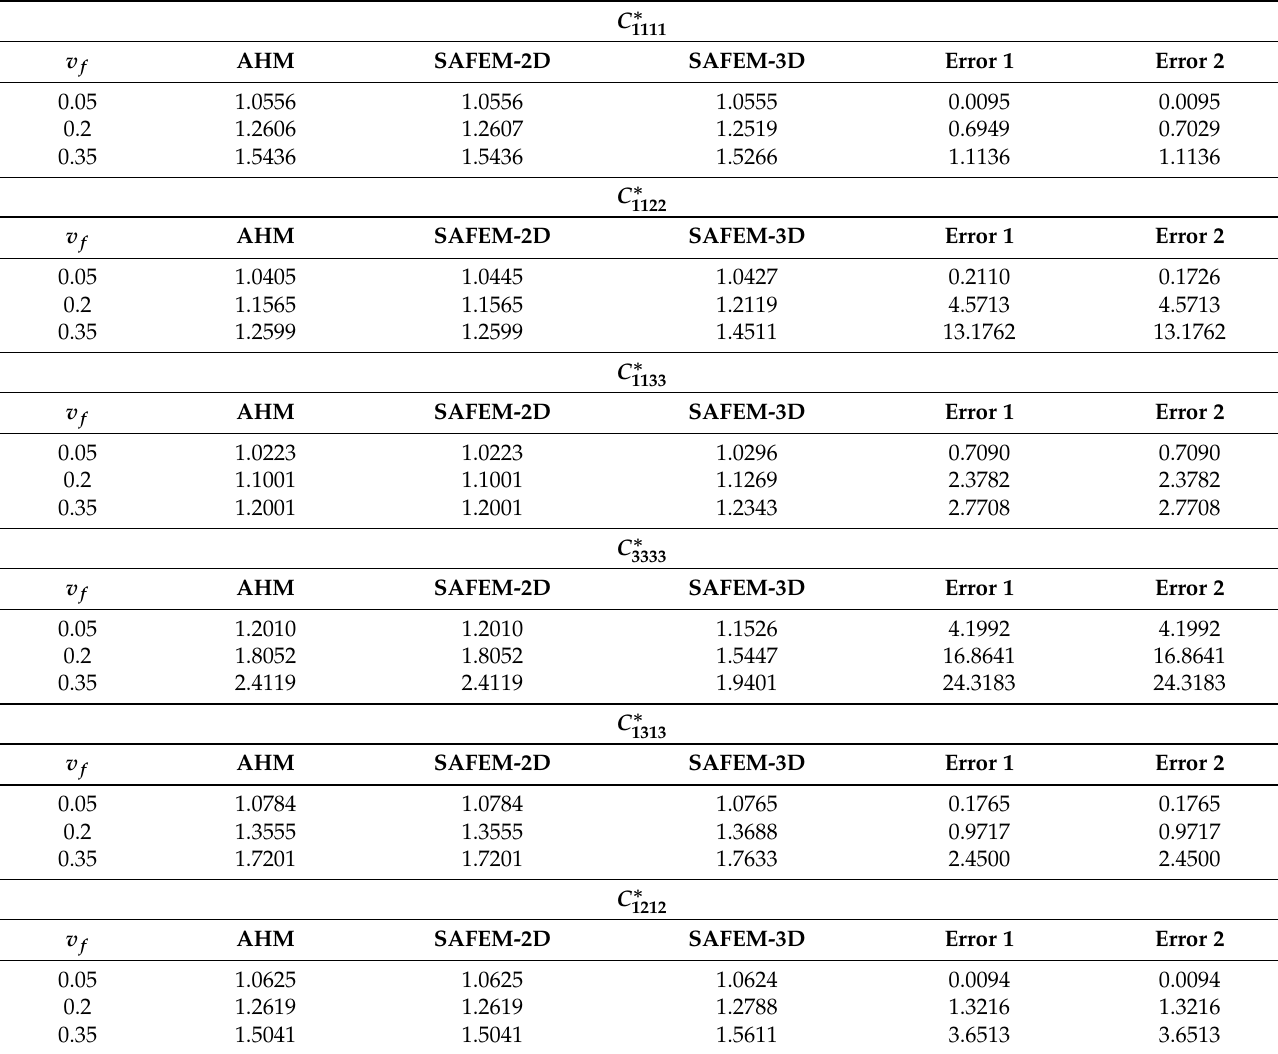
(cid:12) (cid:12) ( C ∗ AHM − C ∗ SAFEM − 3D ) /C ∗ SAFEM − 3D